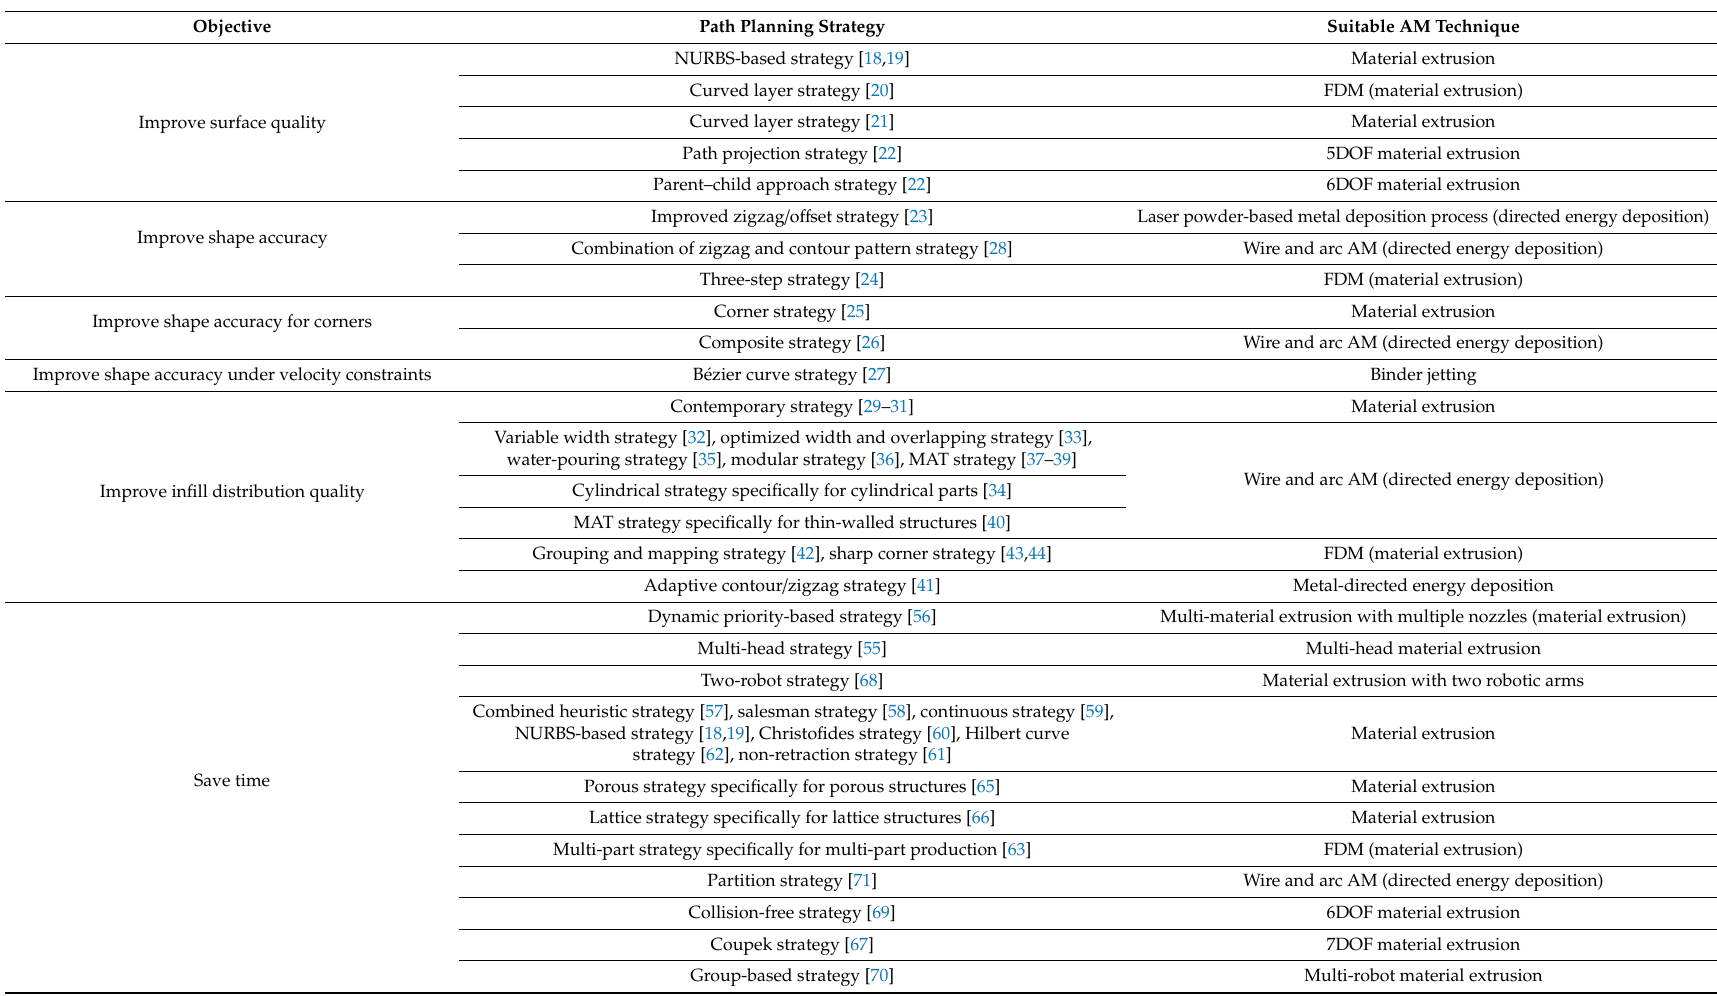
Table 1. Path planning strategies in